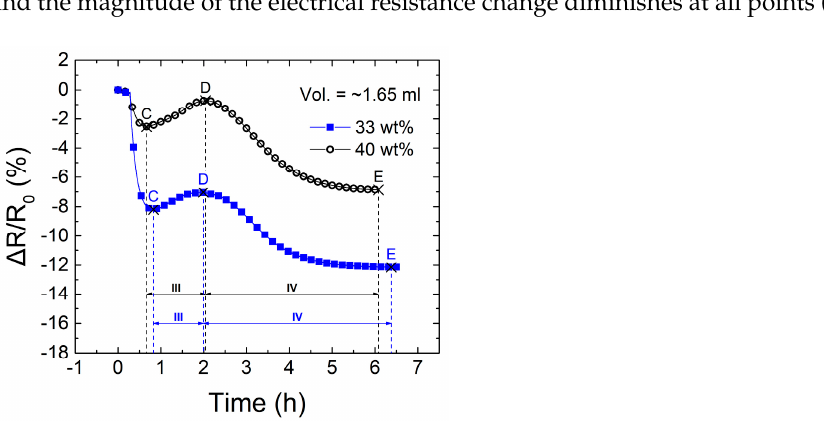
Figure 9. CNTY fractional change of resistance versus time during curing of VER with 33 and 40 wt.% styrene monomer concentrations.